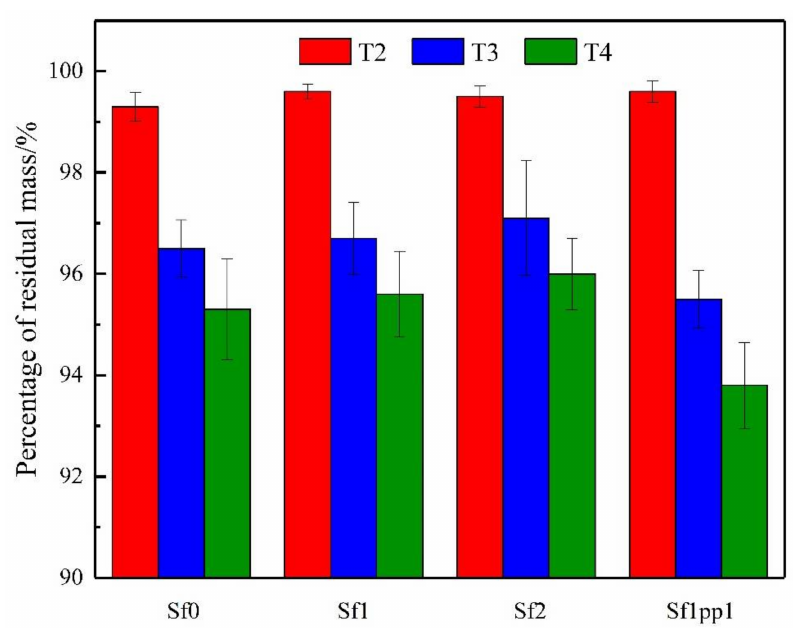
Figure 3. Percentage of residual mass of the repaired systems under high